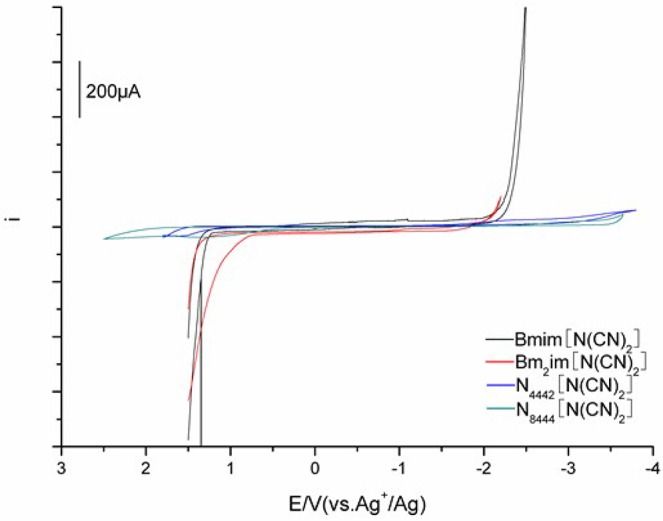
Cyclic voltammograms of [C4mim][N(CN)2] (black), [C4m2im][N(CN)2] (red), N4442[N(CN)2] (blue), and N8444[N(CN)2] (green) measured at 303 K.